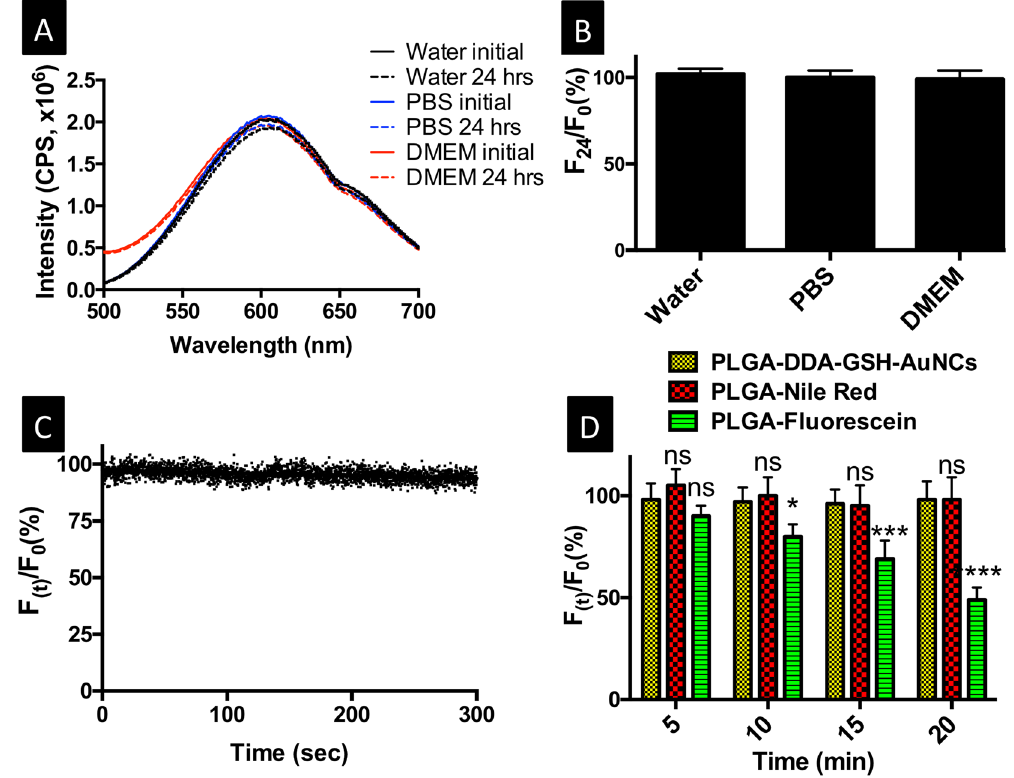
Figure 5. Photostability of PLGA nanoparticles encapsulating DDA-GSH-AuNCs. ( A ) Photoluminescence spectra and ( B ) relative photoluminescence intensity calculated as the ration between intensity after 24 hours of incubation (F 24 ) to the initial intensity (F 0 ) in water, PBS or DMEM as labeled. C ) Photostability of PLGA nanoparticles encapsulating DDA-GSH-AuNCs in DMEM upon kinetic scan ( λ ex = 365 nm, λ em = 605 nm, integration time of 0.1 s, total scan time of 300 S, 150 W xenon lamp). D ) Photostability of PLGA nanoparticles encapsulating DDA-GSH-AuNCs (yellow bars), Nile Red (red bars) or fluorescein (green bars) upon irradiation with (364 nm, 80 mW, 248 mW/cm − 2 ), (568 nm, 30 mW, 93 mW/cm − 2 ) or (488 nm, 30 mW, 93 mW/cm − 2 ), respectively. In ( C , D ): F 0 and F (t) are the initial photoluminescence intensity before irradiation and at each time point as labeled, respectively. Data in ( B ) and (D) are mean ± SD, n = 3 for each group. Statistical analysis in ( D ) was performed by 2-way ANOVA with the Bonferroni post-hoc test. In ( D ), significant difference of PLGA- Nile red or PLGA-Fluorescein in reference to PLGA-DDA-GSH-AuNCs is calculated using (alpha of 0.05) and indicated by: * p < 0.5; *** p < 0.001; **** p < 0.0001; ns: not significant (p >